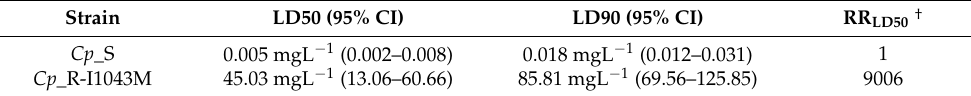
Table 2. Lethal doses observed in resistant and susceptible Cx. pipiens colonies. LD50 (95% CI) = Lethal dose of DFB required to kill 50% of population and its 95% confidence intervals; LD90 (95% CI) = Lethal dose of DFB required to kill 90% of population and its 95% confidence intervals; † Resistant Ratio.